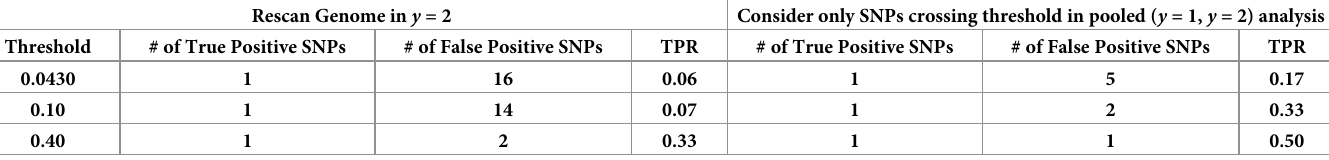
Table 12. True Positive Rates (TPR) for detection of epistasis using the TE-PPLD in initial N = 400 data set, at various thresholds. Rescan Genome in y = 2